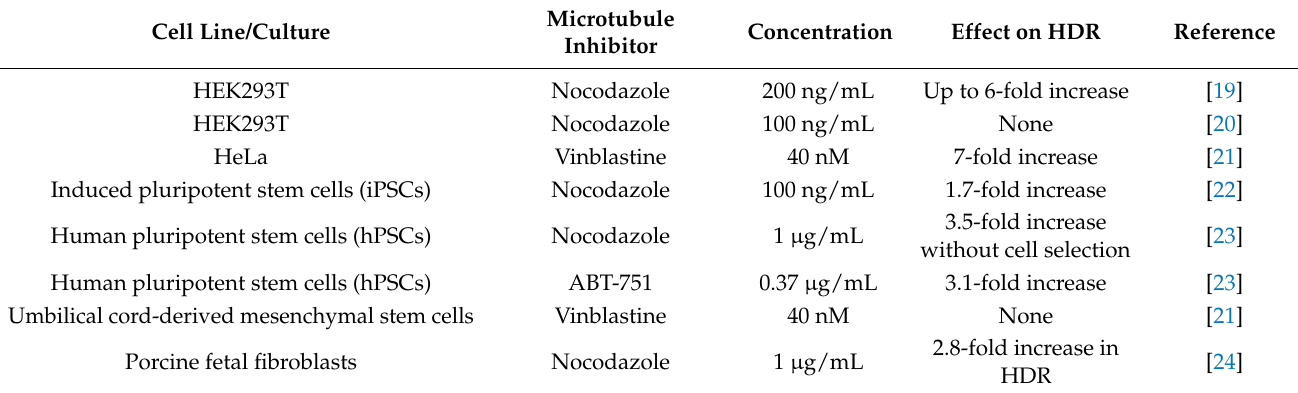
Table 1. Impact of microtubule inhibitors on